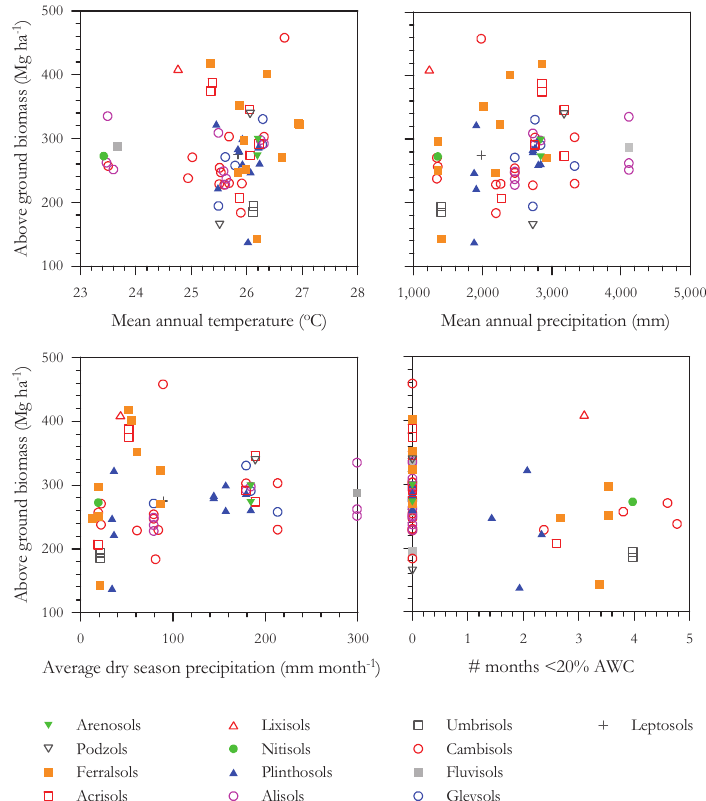
Fig. 14. Relationships between above-ground biomass and climatic